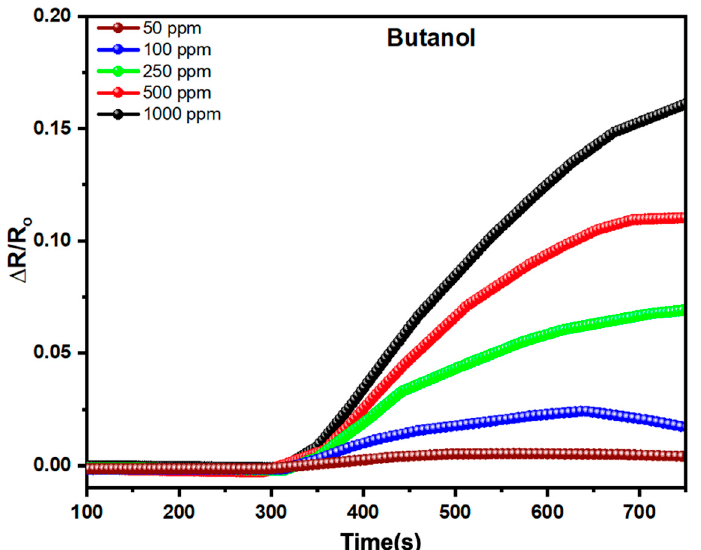
Figure 4. Paper-based graphene–PEDOT:PSS/WS 2 nanotube chemiresistor response for n-butanol gas under different concentrations at RT.